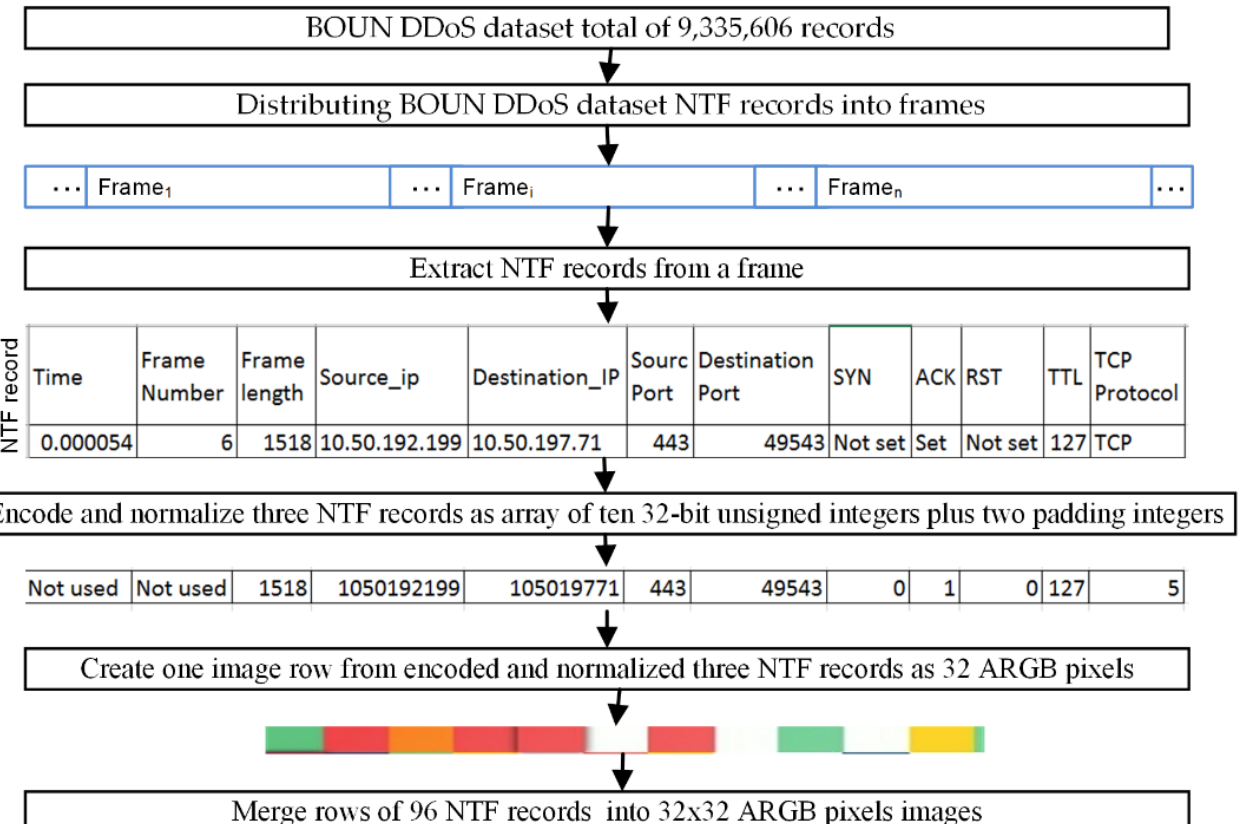
Figure 3. Creating images of frames from the BOUN-DDoS dataset NTF records.